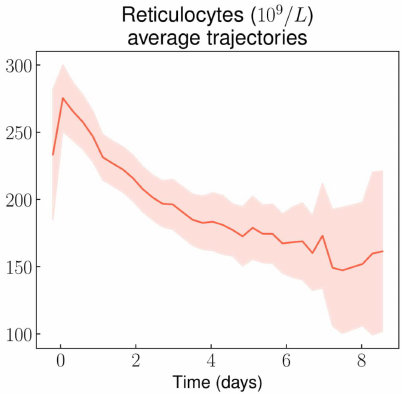
Figure A3. Reticulocytes count average trajectory throughout non-complicated VOC-related hospital stays.